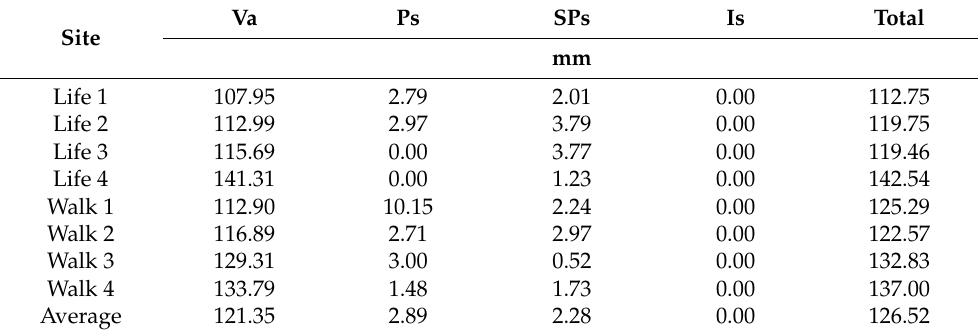
Table 5. Results of evaluating the infiltration rate per land use type of the study sites.